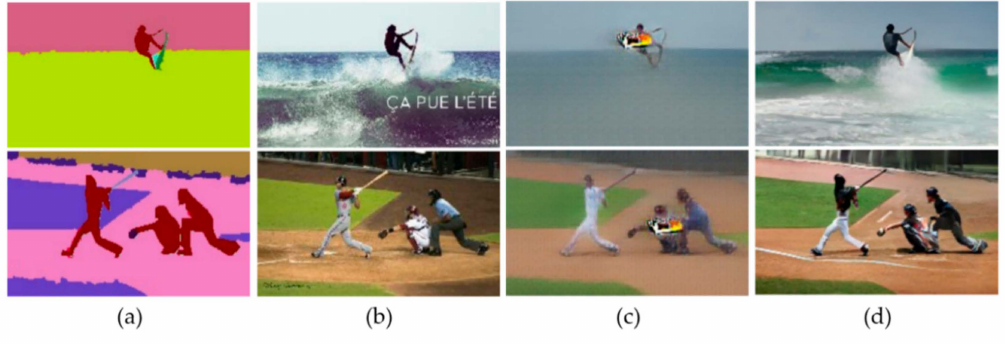
Figure 2. ( a ) Segmentation image, ( b ) original image. When ( a ) is given as input, ( c ) is the result of Pix2PixHD, and ( d ) is the result of